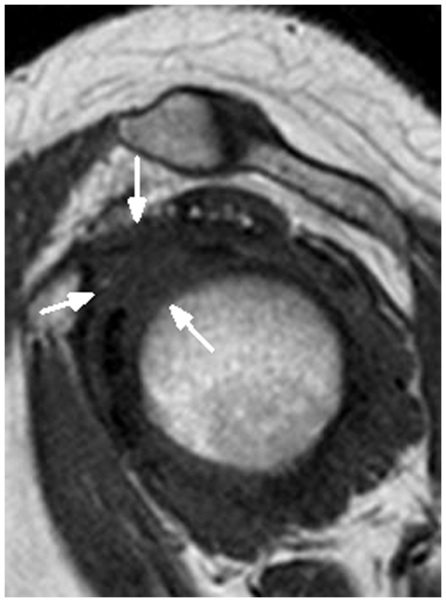
A 57-year-old male patient with clinical evidence of right frozen shoulder.Sagittal oblique, T1-weighted image (TR/TE = 550 ms/15 ms) shows the complete obliteration of subcoracoid fat triangle and distinct fatty tissue surrounding the CHL as having disappeared, and the CHL cannot be measured (arrows).